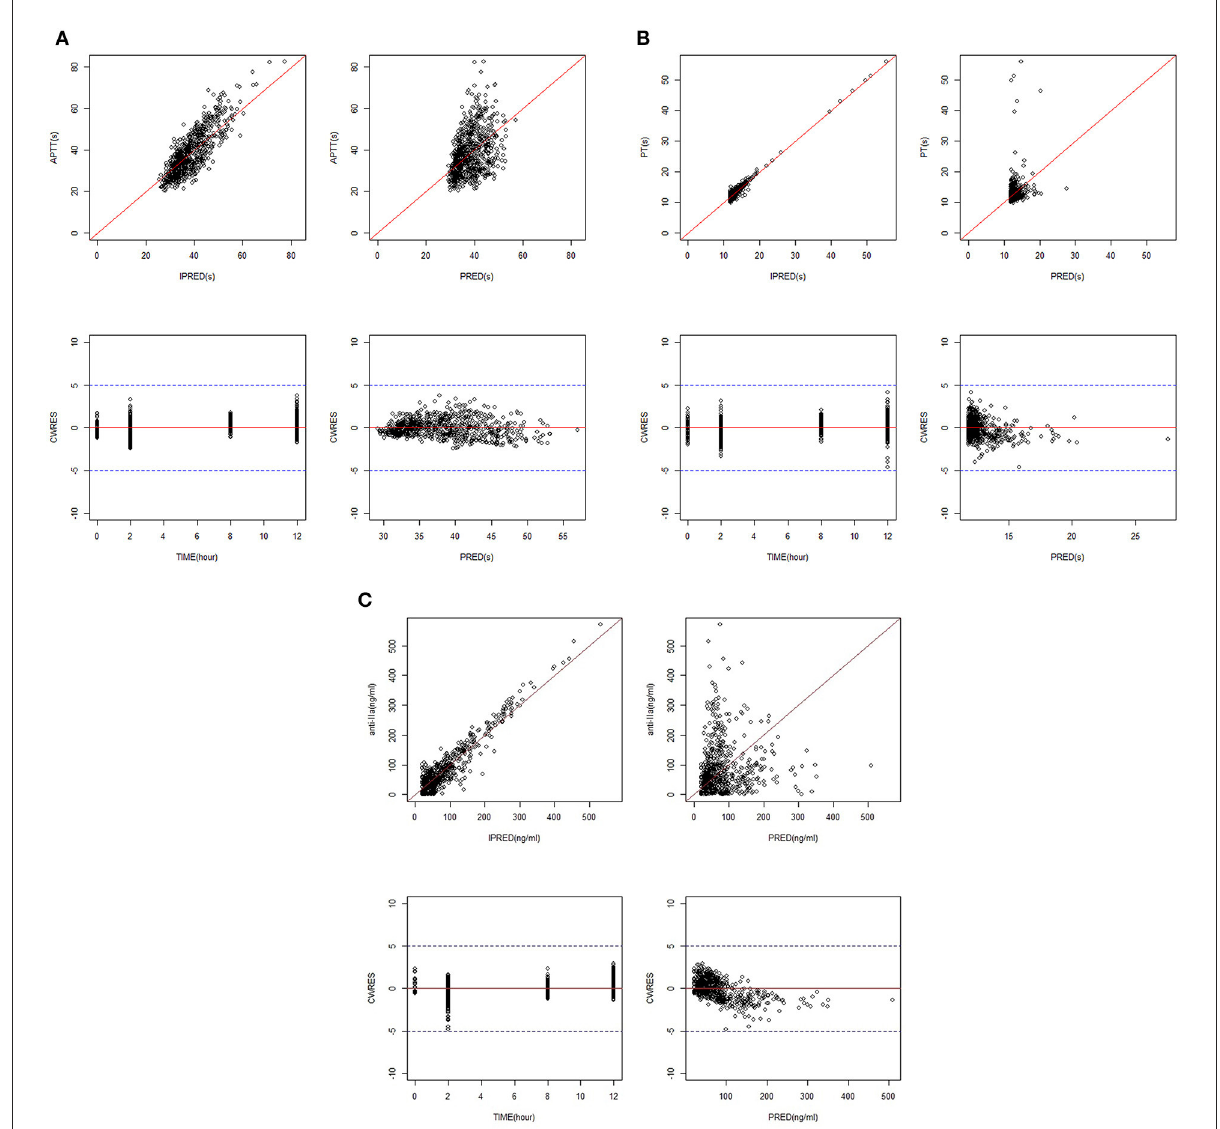
FIGURE1 GoF plots for the integrated PK/PD model. (A) APTT. (B) PT. (C) Anti-FIIa. Annotation: The standard goodness-of-fit plots for APTT, PT, and anti-FIIa in the integrated PK/PD